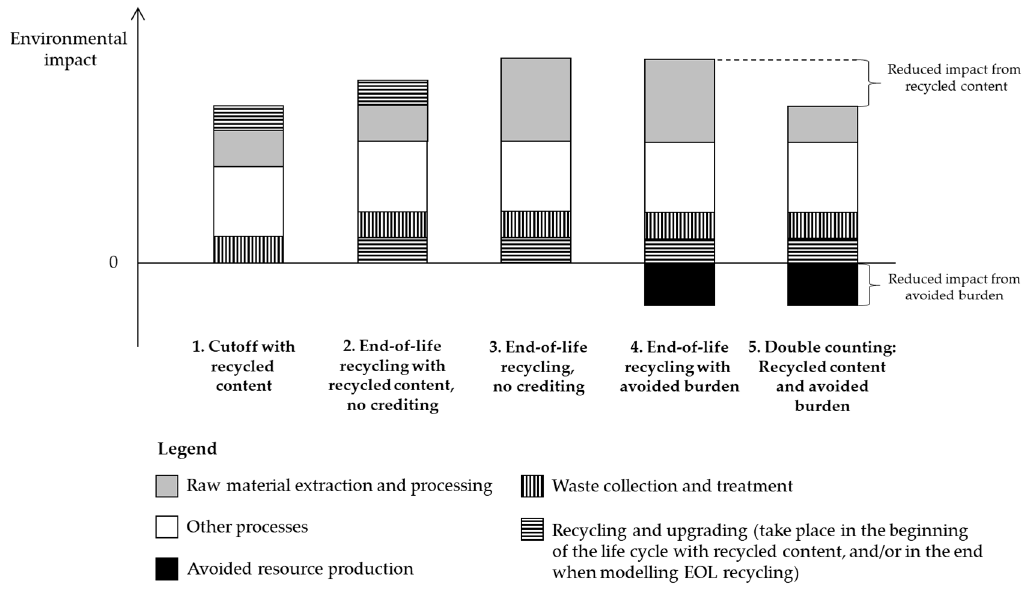
Figure 2. Schematic illustration of how environmental impacts vary depending on the selection of EOL modelling approach, if the study uses the expected setup for cutoff (1) or EOL recycling (4), or apply a hybrid version (2, 3, or 5). Using the EOL approach without giving any credits for recycling (2 or 3) leads to a conservative estimation of the environmental and resource impacts of LIBs, whereas modelling both recycled content and avoided burden (5) implies double counting which may underestimate the impact. Bar sizes are indicative only and do not reflect actual results.